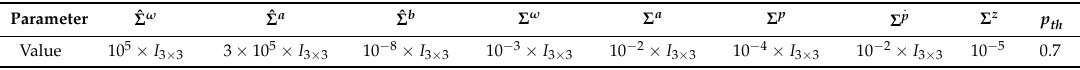
Table A1. Noise and parameter settings for the presented kinematics estimation